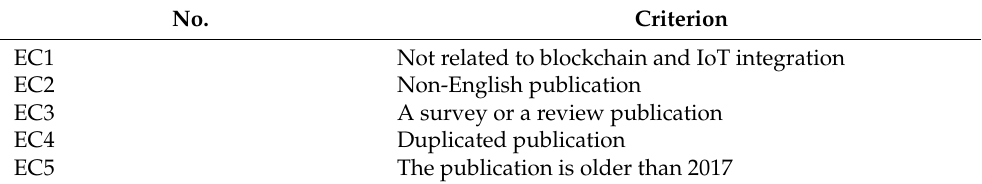
Table 2. Exclusion criteria.